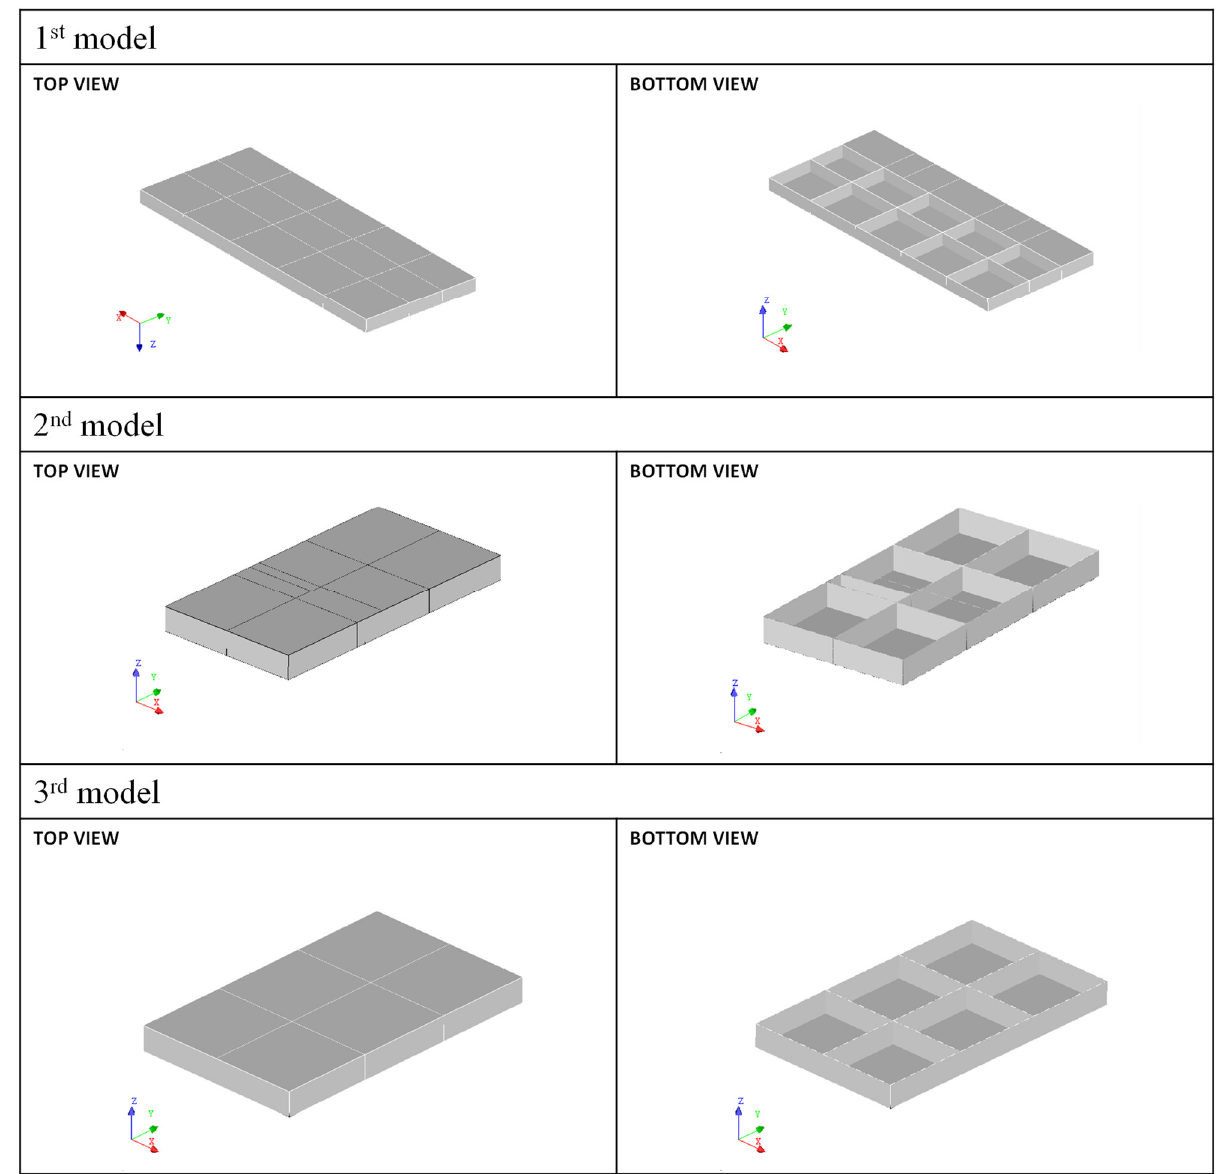
Figure 9. Hatch cover 3D model.